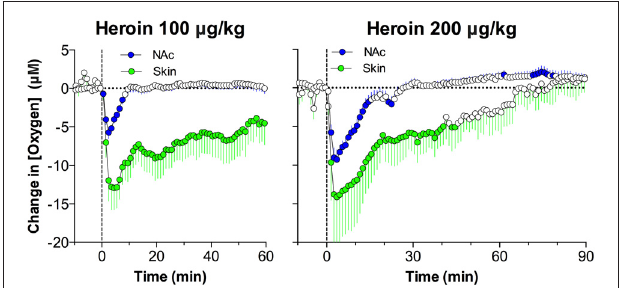
FIGURE 6 | Comparison of changes in oxygen levels in the NAc and subcutaneous space induced by intravenous heroin injections at two low doses. Data are shown as changes in mean ( ± SEM) concentrations analyzed at slow, 1-min time resolution. Vertical hatched lines show the onset of injection. Since absolute values of dissolved oxygen in the subcutaneous space are larger than those in the NAc, heroin induced larger oxygen concentration decreases (in µ M) in this peripheral location. When calculated as relative change, the amplitude of oxygen decreases was similar in both recording locations. Original data were published in Solis et al.